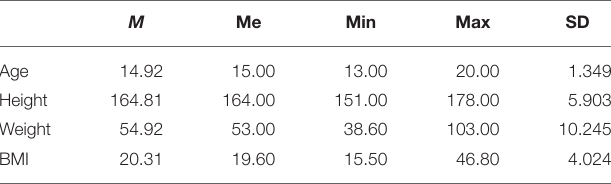
TABLE 1 | Selected characteristics of the study group ( n =